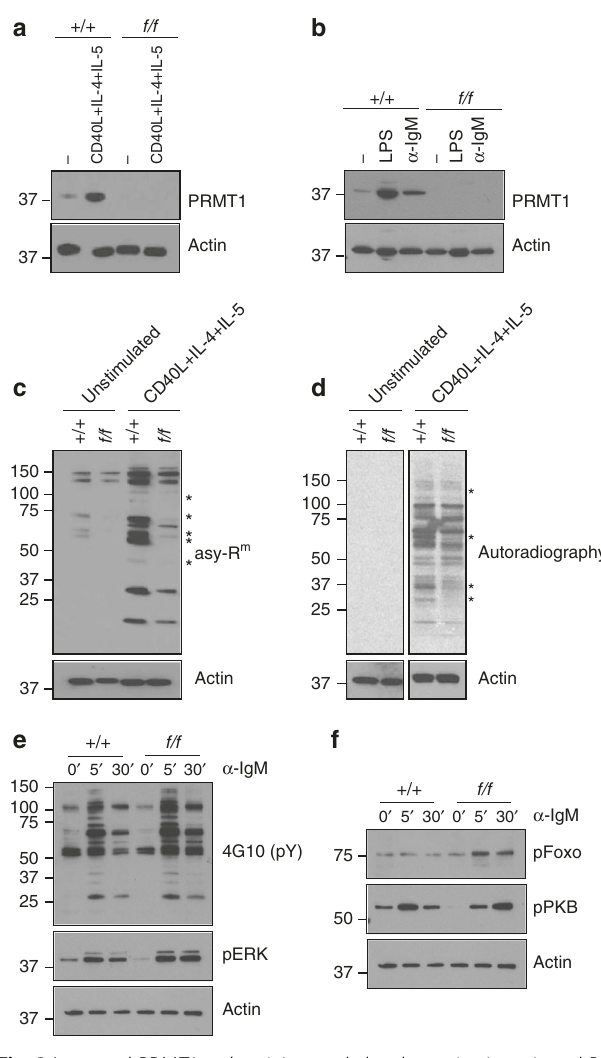
Fig. 2 Increased PRMT1 and arginine methylated proteins in activated B cells. Immunoblot analysis of control ( + / + ) and Prmt1 -de fi cient ( f/f ) splenic B cells for PRMT1 induction after a 2 days stimulation with CD40L and IL-4 and IL-5 or b 2 days stimulation with LPS or F(ab ′ ) 2 anti-IgM as indicated and compared to actin loading control. c Distribution of asymmetric-dimethylated arginine (asy-R m ) containing proteins in unstimulated and 2 day CD40L + IL-4 + IL-5 stimulated control (+/+) and Prmt1 -de fi cient ( f/f ) splenic B cells, using speci fi c antibody and compared to actin loading control. d Ex vivo methylation assay. Unstimulated (left panel) or day 2 CD40L + IL-4+ IL-5 activated (right panel) control ( + / + ) and Prmt1 -de fi cient ( f/f ) B cells were grown for 3 h in the presence of L- [methyl-3H]methionine and protein synthesis inhibitors. Autoradiography of lysates reveals methylated proteins. Asterisks in c , d indicate proteins that are differentially methylated between control and Prmt1 -de fi cient B cells. e , f B cells were activated with F(ab ′ ) 2 anti-IgM for the indicated time points. Western blot analysis of the whole-cell lysates shows the level of phospho-tyrosine (4G10), pERK (T202/Y204), e pFoxo1(pS256) and pPKB (S473) f . Actin is used as a loading control. Similar results were obtained in three independent experiments in which each sample was derived from a pool of three mice. Uncropped images of blots are presented in Supplementary Fig.